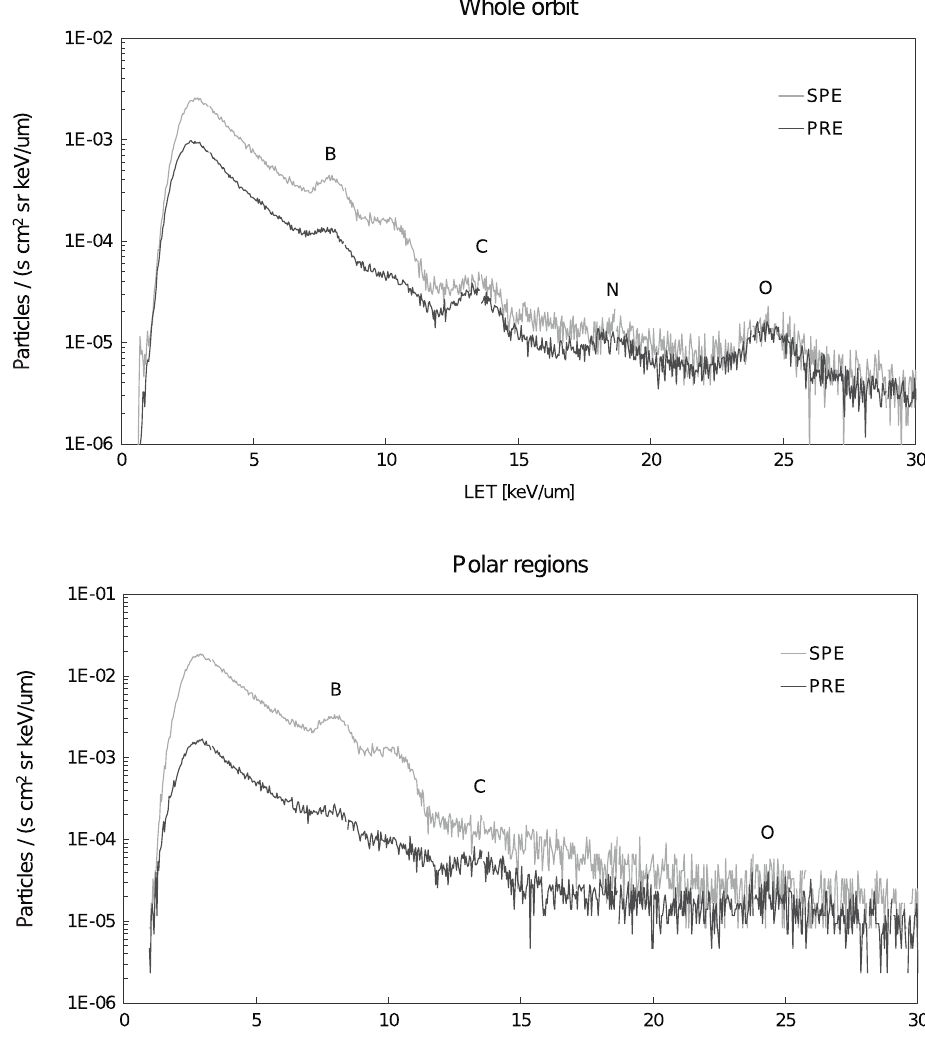
Fig. 9. The SPE energy spectrum compared with the quiet Sun spectrum (PRE). Upper panel: energy loss spectra integrated over the whole orbit. Lower panel: energy loss spectra integrated in the polar regions